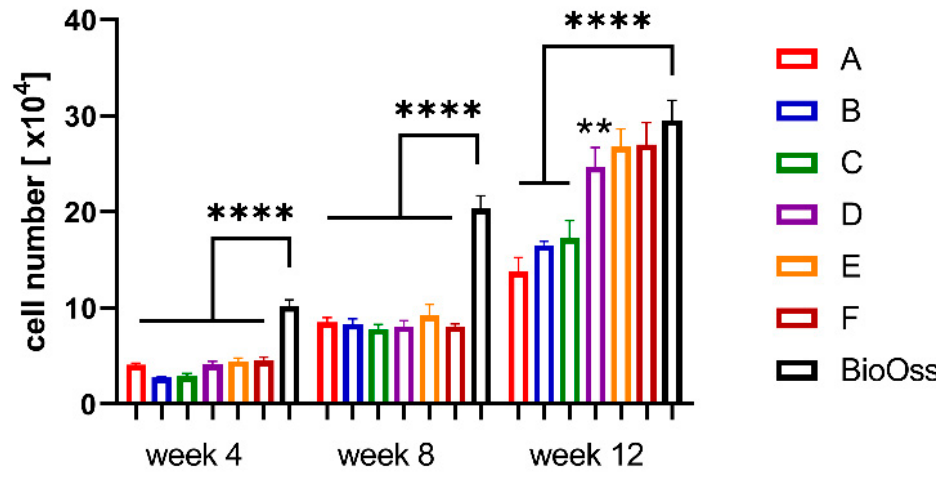
Figure 3. Proliferation of MSCs on/in the scaffolds depending on the various porosities after 4, 8 and 12 weeks in comparison to BioOss ® (strand-to-strand-distance µm/pore size µm: A: 430/100; B: 560/230; C: 690/360; D: 820/490; E: 950/620; F: 1080/750; * p ≤ 0.05, ** p ≤ 0.01, *** p ≤ 0.001, **** p ≤ 0.0001, mean ± standard deviation, n = 5)